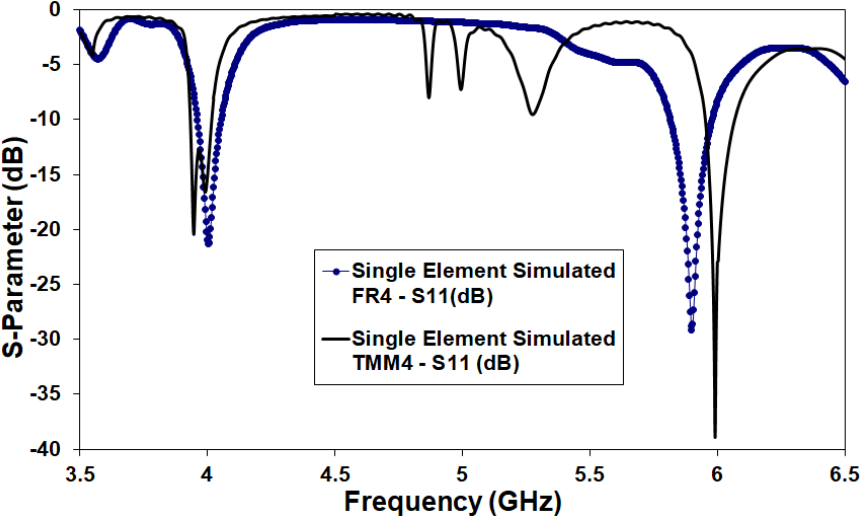
Figure 4. Simulated S 11 (dB) response of the single − element Minkowski − Sierpinski fractal antenna using low − end FR4 and high − end Rogers TMM4 substrates.